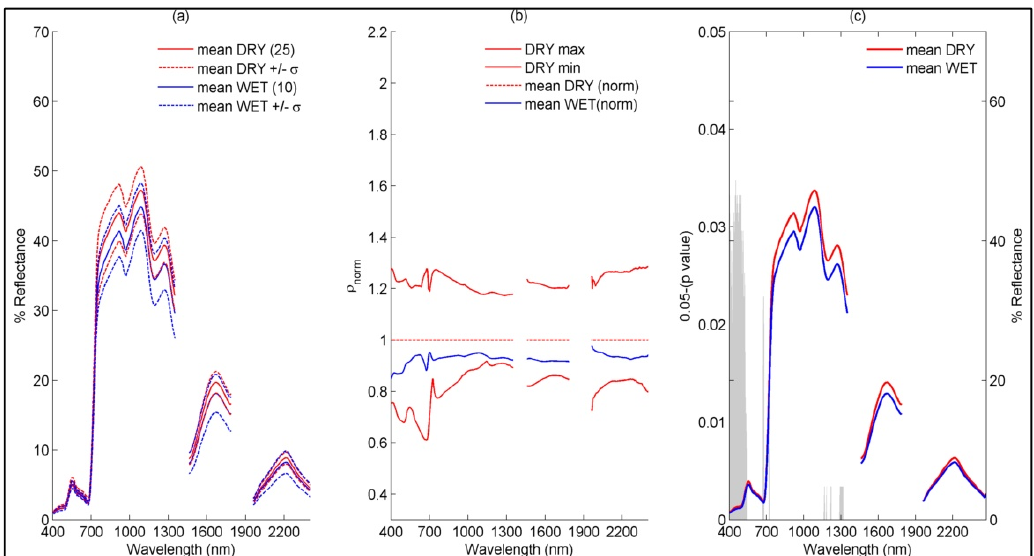
Figure 3. ( a ) Average spectra (along with standard deviation) measured in nadir direction above canopy of DRY and WET class on 5 and 9 July 2013; ( b ) Shape filter space of DRY class with mean of normalized (with respect to DRY ) spectra of WET class vegetation; ( c ) Results of wavelength wise Mann–Whitney U test between WET and DRY location spectra showing significant differences in grey scale ( p -value < 0.05). Number of sampling locations is given in bracket in the legend of plot 3a.